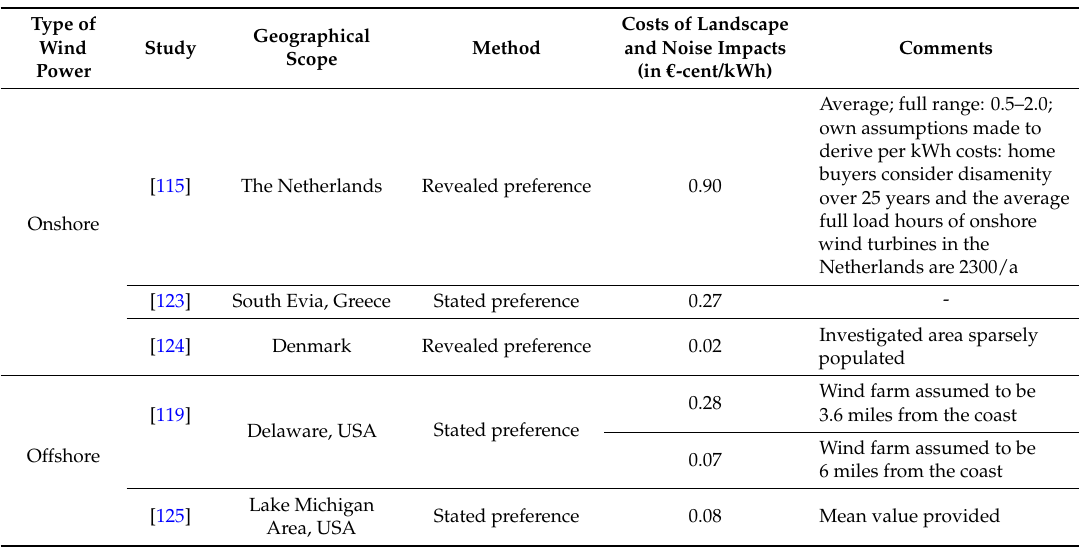
Table 8. Costs of landscape and noise impacts of onshore and offshore wind power plants at various locations in Europe and the USA according to several